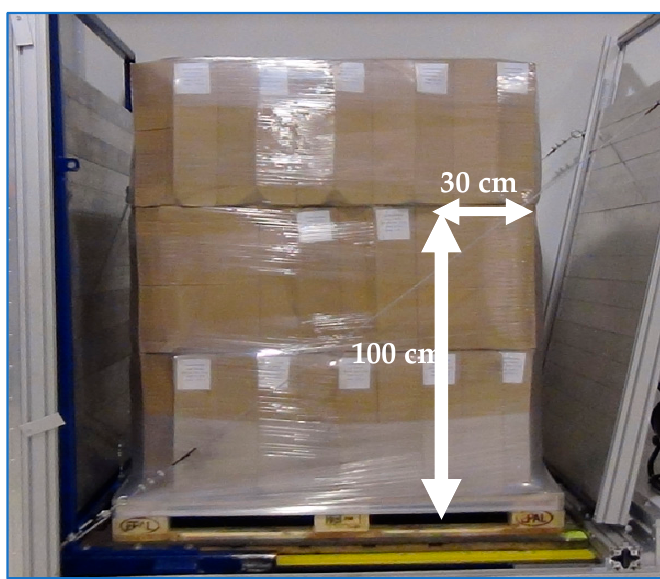
Figure 9. Permissible cargo deviation after stability test.